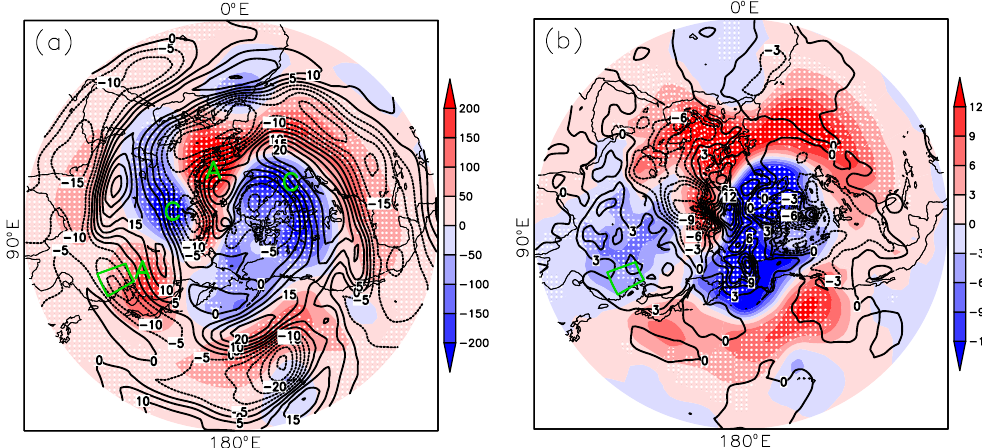
Figure 6. Distribution of the global atmospheric circulation anomalies, (a) Z500 (shading) and U200 (contour); the white dots indicate Z500 anomalies exceeding the 95% confidence level ( t test), and (b) SLP (shading) and SAT (contour) during 16–21 December 2016; the white dots indicate SLP anomalies exceeding the 95% confidence level ( t test). The anomalies here are calculated with respect to the period of 1981–2010.